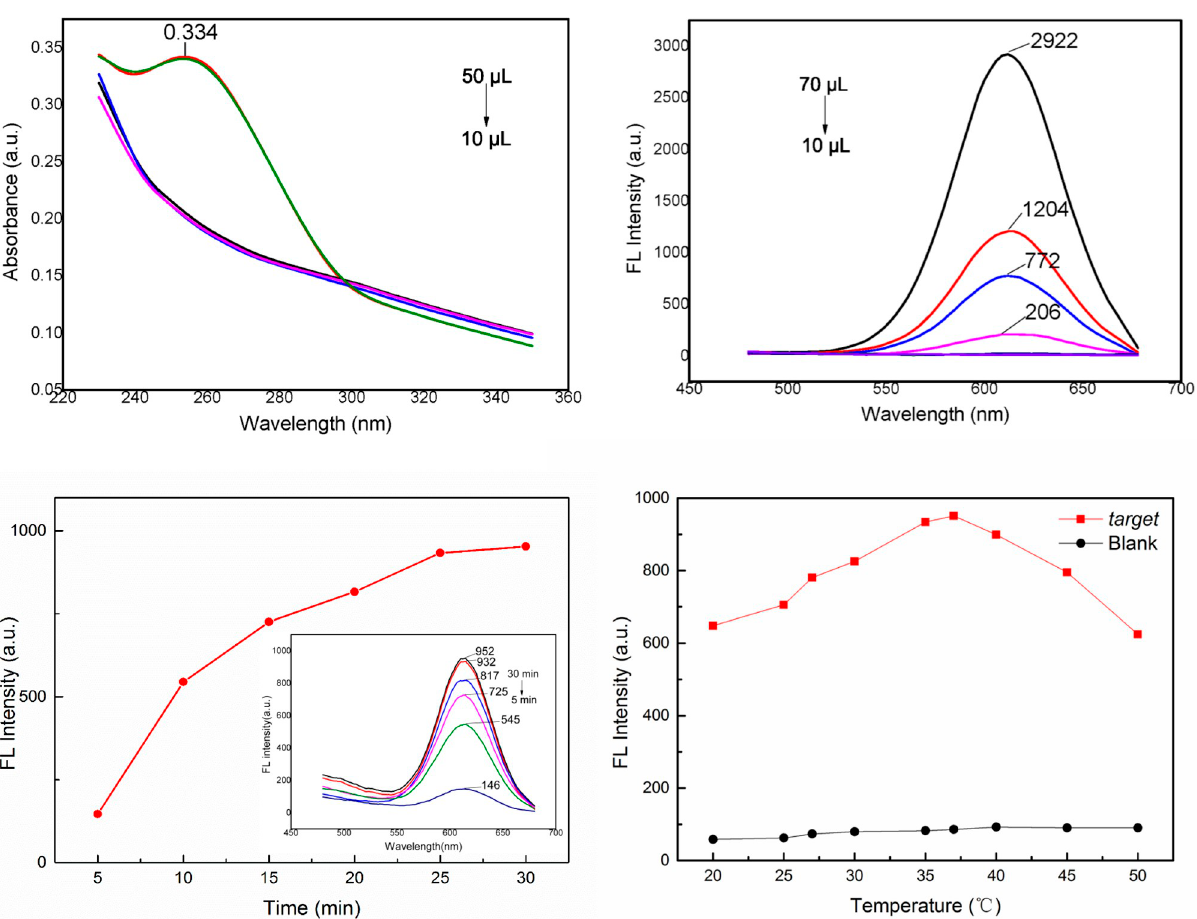
Fig 6. ( a ) UV-visible absorption spectrum of 10 μ L of 1 mg•mL -1 streptavidin-coated MNPs decorated with 50 μ L of 10 nM aptamer. ( b ) Fluorescence spectra of different concentrations (from 70 μ L to 10 μ L) of ssDNA2@CdTe QDs of 30 μ g � mL -1 ssDNA2@CdTe QDs. ( c ) Fluorescence spectra of aptamer&QDs-ssDNA2@MNPs after different incubation times with S . Typhimurium . ( d ) Fluorescence spectra of aptamer&QDs-ssDNA2@MNPs incubated with S . Typhimurium at different incubation temperatures.